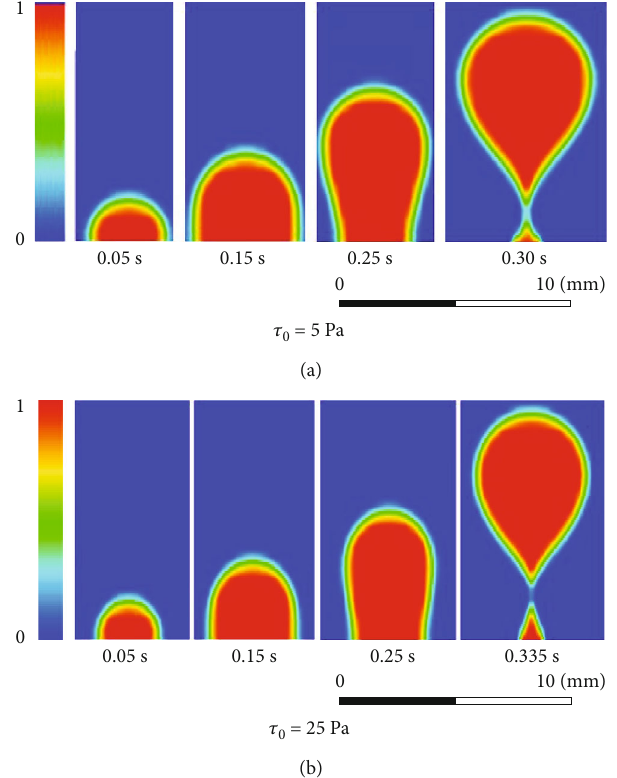
Figure 7: Bubble formation and escape processes in liquids with di ff erent τ